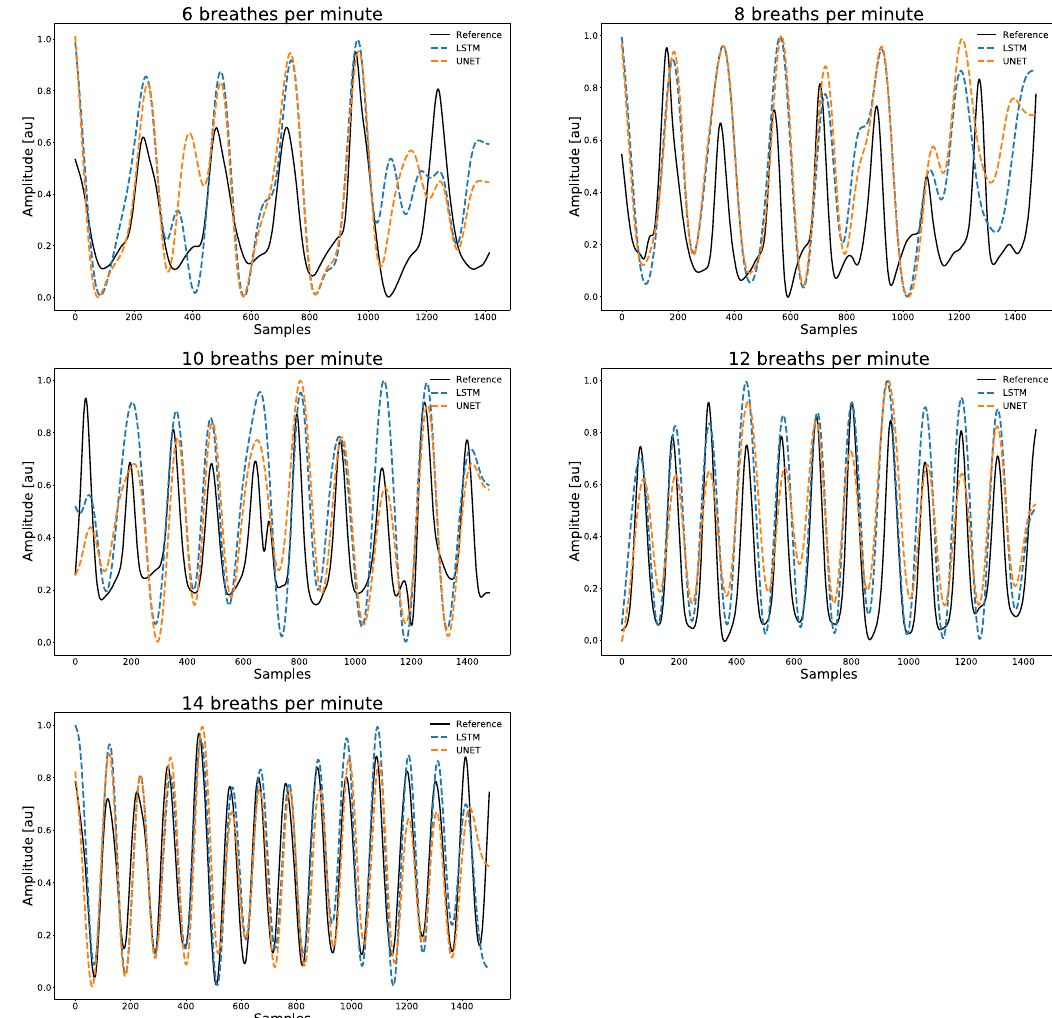
Table 1. Participant information for the study, stratified by health status.